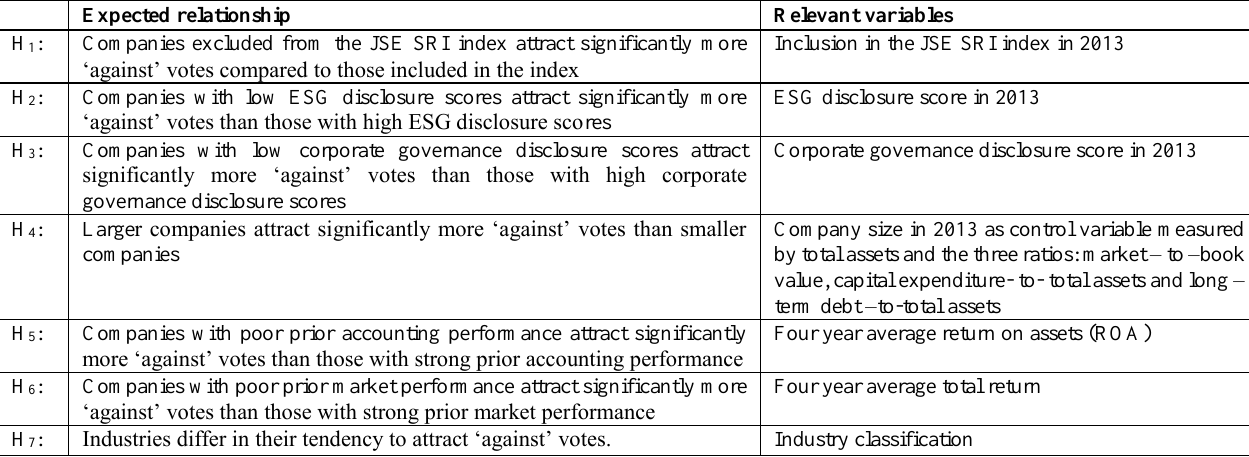
Table 1: Research hypotheses Expected